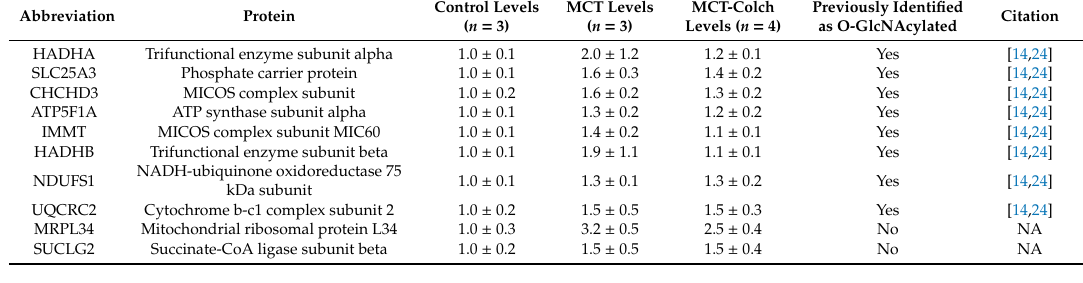
Table 1. Summary of top 10 mitochondrial proteins identified in proteomics experiment.